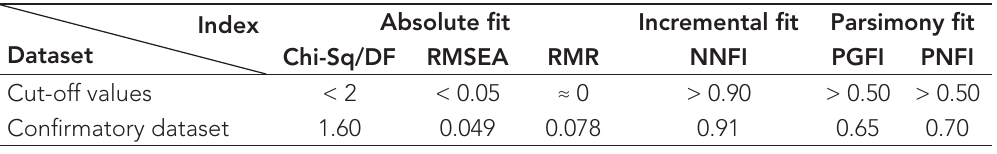
Table 3: Absolute, incremental and parsimony of fit indices for the confirmatory